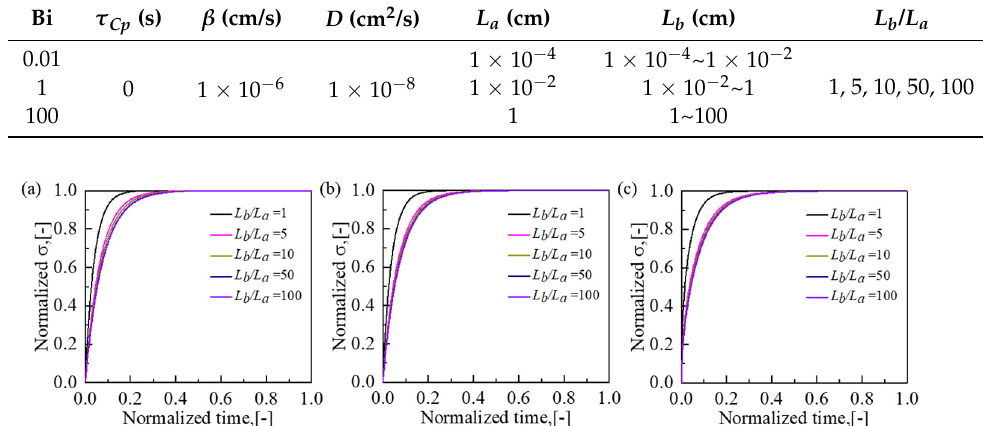
Figure 2. Conductivity relaxation curves of different Bi. ( a ) Bi = 0.01, ( b ) Bi = 1, ( c ) Bi = 100.